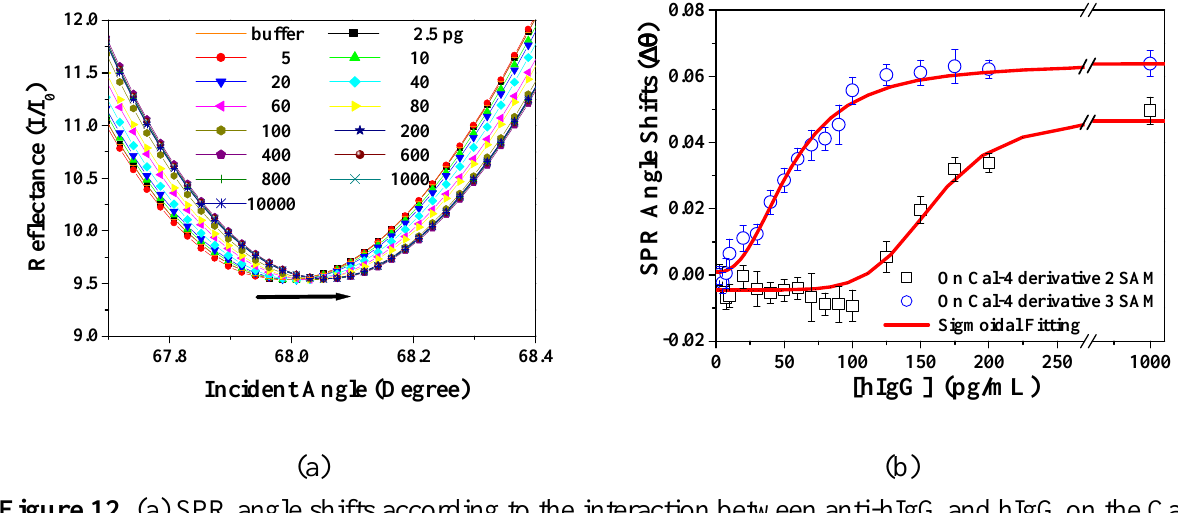
Figure 12 . (a) SPR angle shifts according to the interaction between anti-hIgG and hIgG on the Cal-4 derivative 3 SAM. (b) Dose-response curves of anti-hIgG immobilized sensor chip represented by SPR angle shifts according to the interaction between anti-hIgG and hIgG on the Cal-4 derivative 2 (rectangular) and 3 (circle) SAMs. Solid line indicates the result of sigmoidal